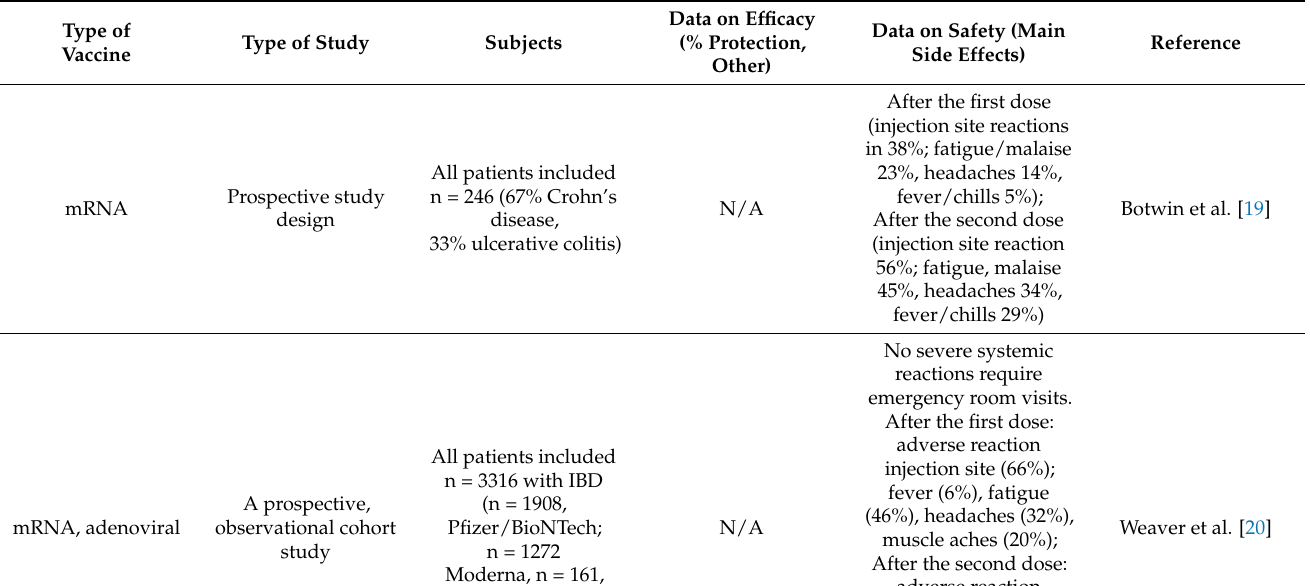
Table 1. Summarized COVID-19 vaccine studies on safety profile, efficacy, and adverse effects rate in patients with inflammatory bowel